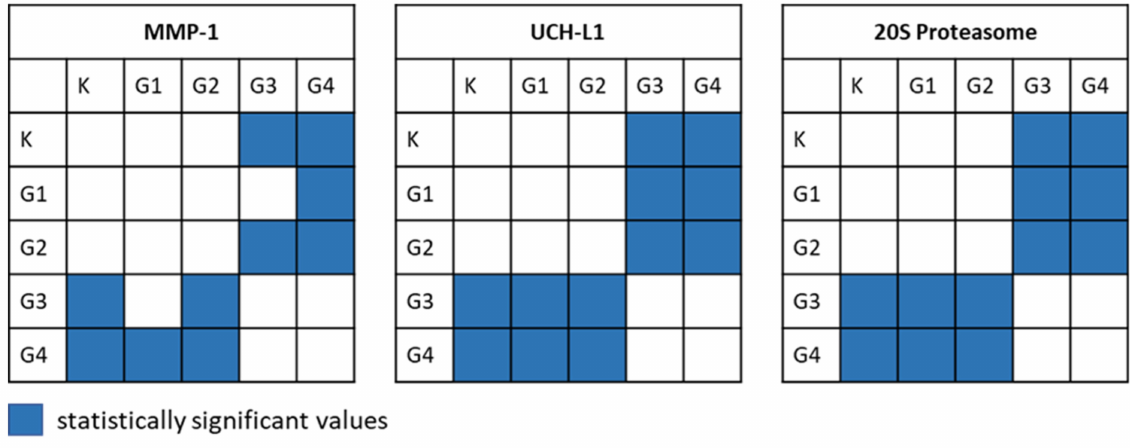
Figure 3. Graphical representation of the Dunn–Bonferroni post hoc test